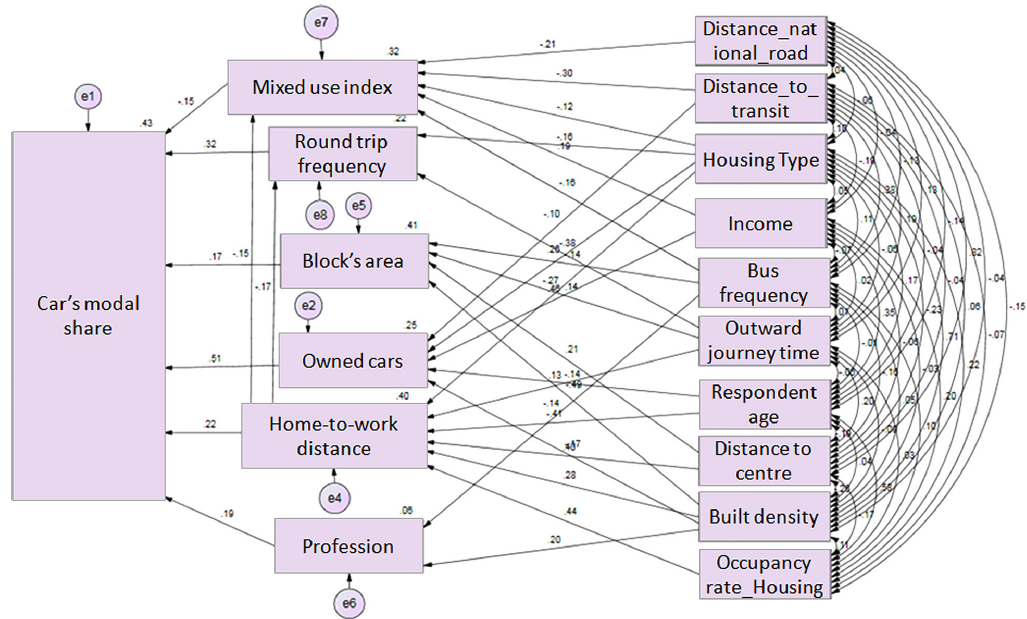
fig. 12. Path analysis of the modal share of the car.